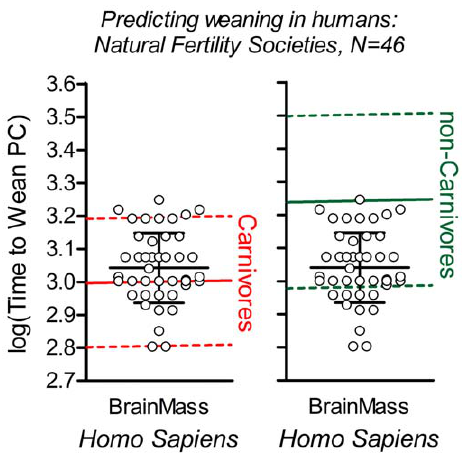
Figure 4. Dietary profile is a predictor of time to weaning. To illustrate the importance of the grouping variable ‘dietary profile’ independently of the grouping variable ‘limb biomechanics’, the grade shift shown in Fig. 3, of about 0.25 units along the Y-axis, has been compensated for by a shift between the left (filled circles; species that can assume plantigrade hindlimb position) and right (open circles; ‘non- plantigrade’ species, which cannot assume plantigrade hindlimb position) Y-axes. In this way, original data rather than values corrected for residual variance can be shown for both groups. Carnivorous, omnivorous and herbivorous species are shown red (N=17), blue (N=23) and green (N=27), respectively. Double circle: humans. Solid lines: Model II linear regression (reduced major axis) on all species within in each dietary category (independently of limb biomechanics) are shown in matching colors. R 2 - and p-values from the multiple regression analysis described in main text are given in the diagrams. For full model equation see main text. The difference between this R 2 -value and the R 2 -value in Fig. 3 corresponds to the additional amount of variance accounted for by the grouping variable ‘dietary profile’.